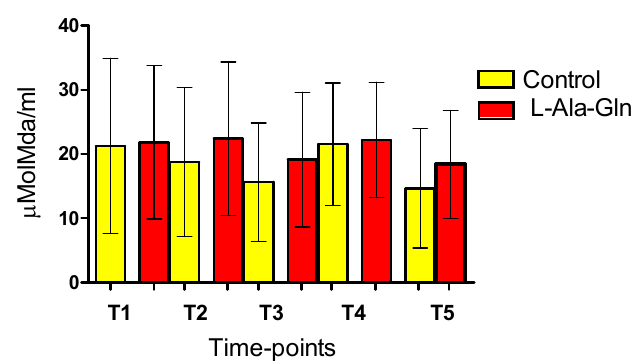
FIGURE 3 - Thiobarbituric acid-reactive substances concentrations (micromoles of malondialdehyde per ml of plasma) in saline (control) and L-Ala-Gln-treated patients. Bars represent mean ± SD of control (yellow bars) and L-Ala-Gln (red bars) groups during different time-points. Groups studied are not significantly different by ANOVA test (Tukey).